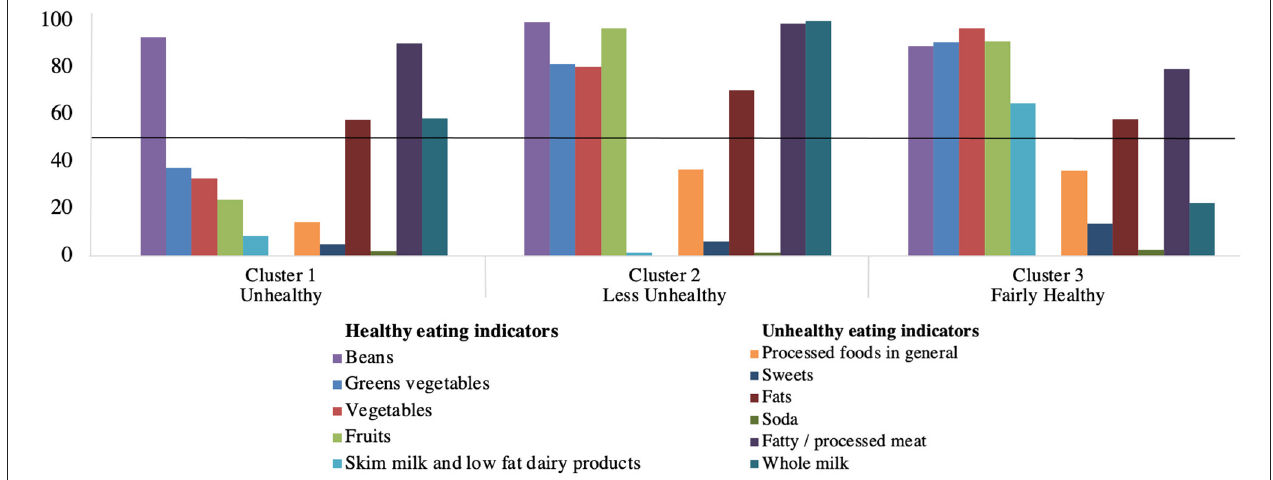
FIGURE 1 | Consumption frequency of the groups of healthy and unhealthy eating indicators, according to the clusters of older adults, Viçosa, State of Minas Gerais, Brazil, 2009 ( n = 621). When the probability of regular consumption of an indicator is above 50% (y-axis), this food group is a characteristic that determines the cluster